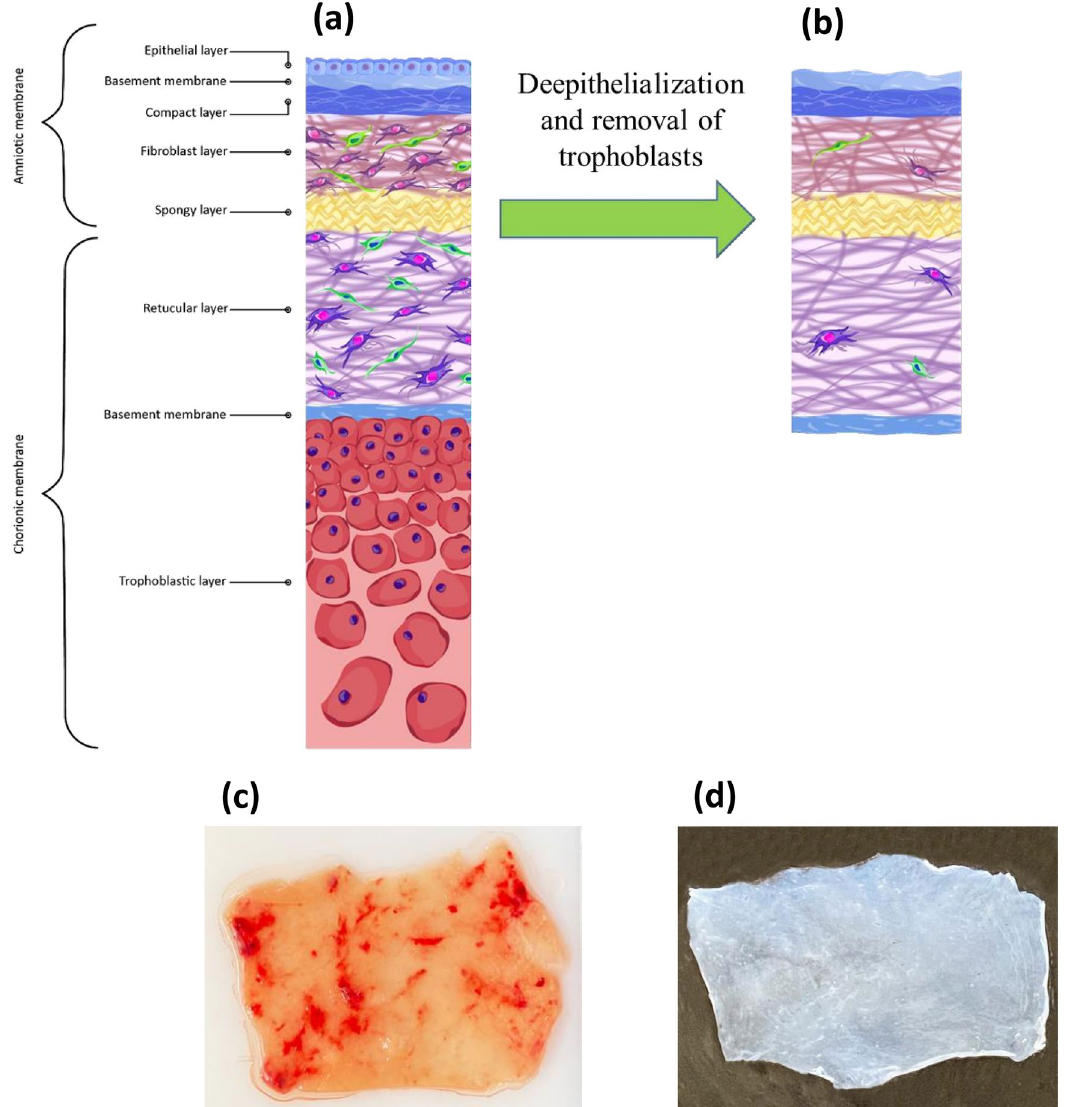
Figure 1. ( a ) Histological features of fresh amniochorionic membrane (fACM); ( b ) histological features of dbACM; ( c ) macroscopic features of fACM; macroscopic features of